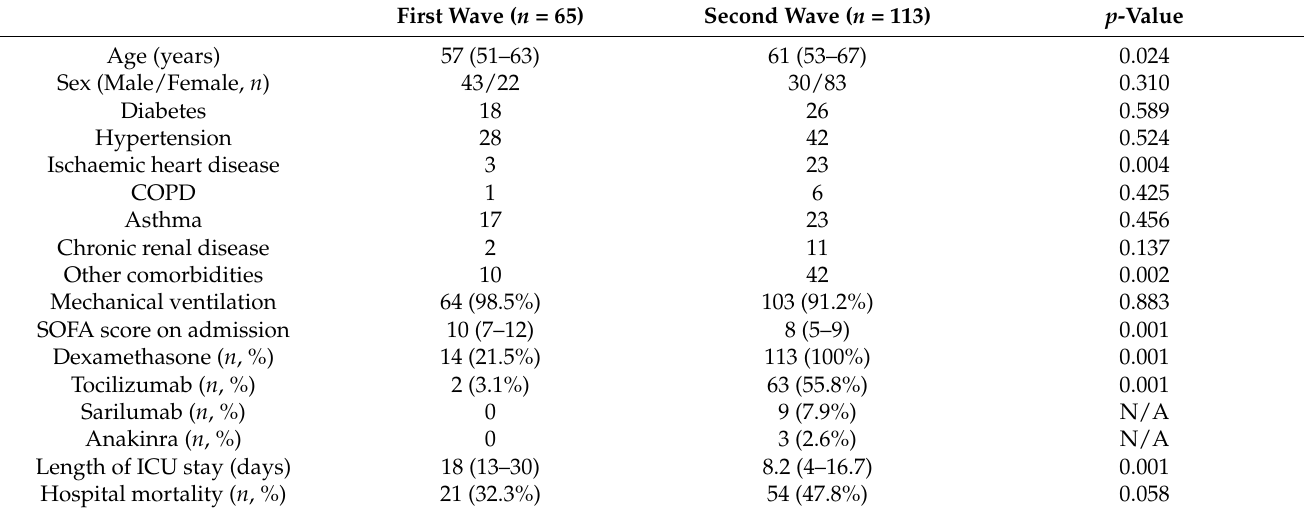
Table 1. Demographics, treatment modalities, and outcomes in COVID-19 patients admitted in the first and second wave. First Wave ( n = 65) Second Wave ( n =